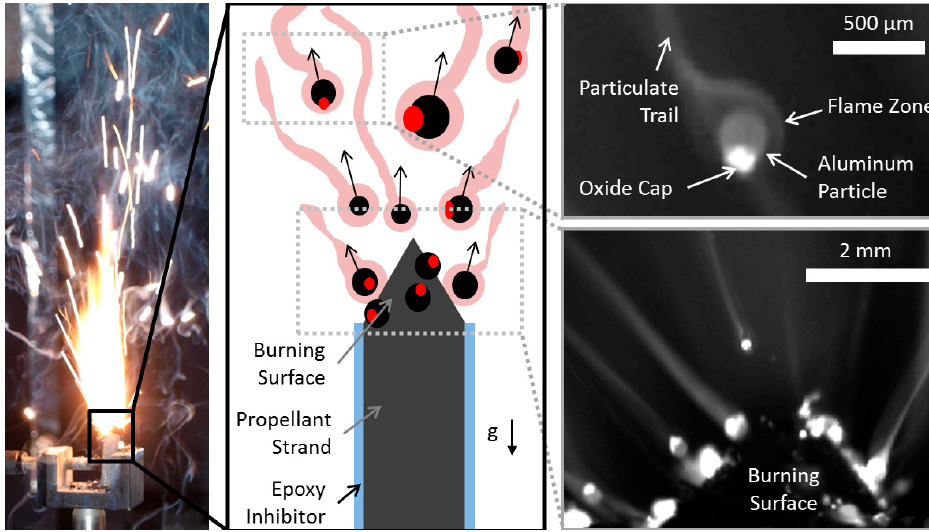
Figure 37. Stick’s burning surface. Reprinted with permission from Ref. [49] (2017).